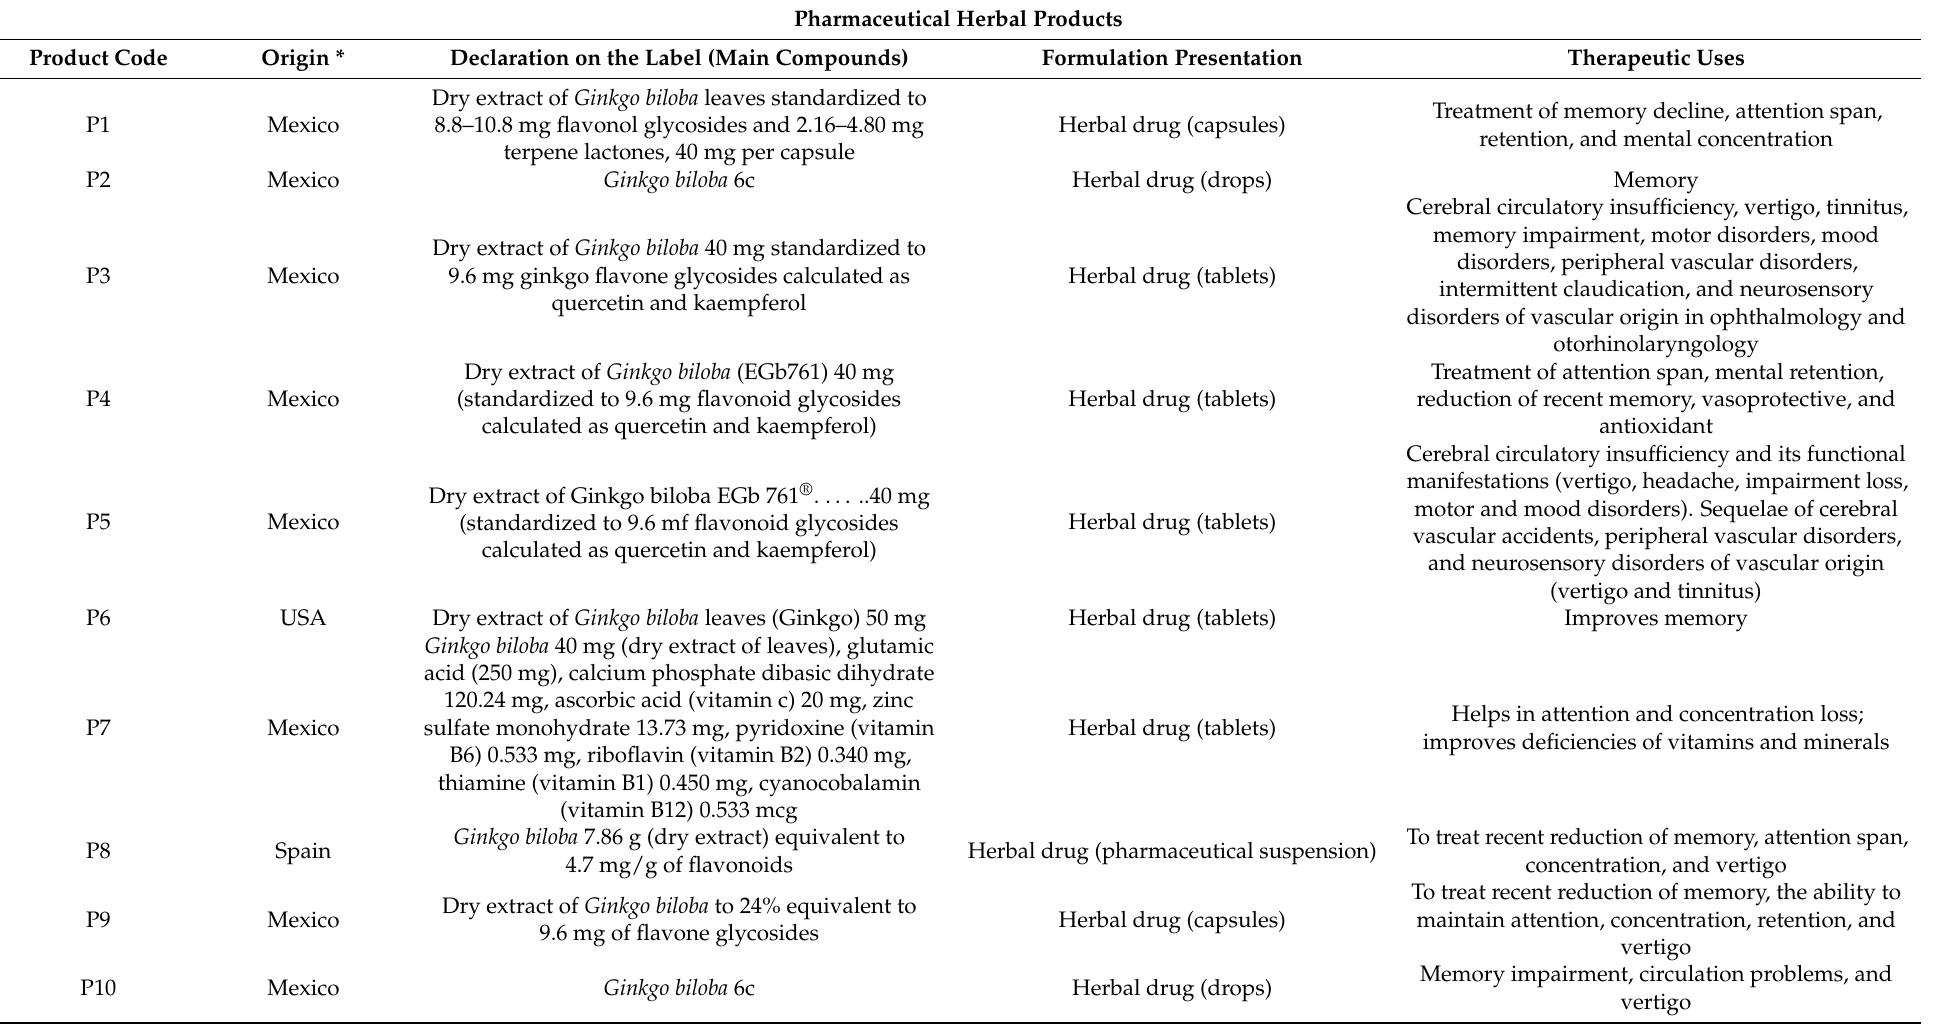
Table 1. Characteristics of products investigated containing Ginkgo biloba